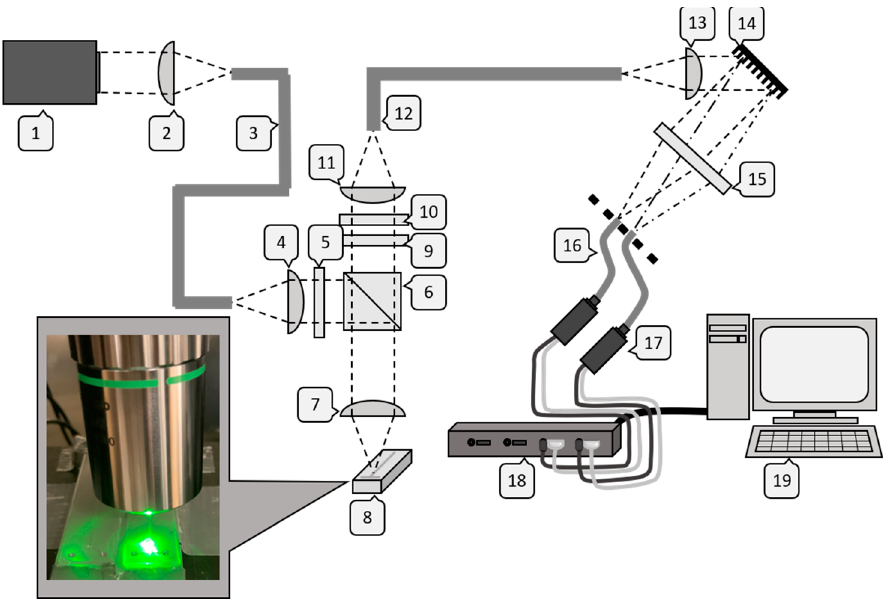
Figure 2. Optical set-up: laser stage #1–3, probe stage #4–7 and #9–12, microchannel #8, photometric detection stage #13–18, software #19.